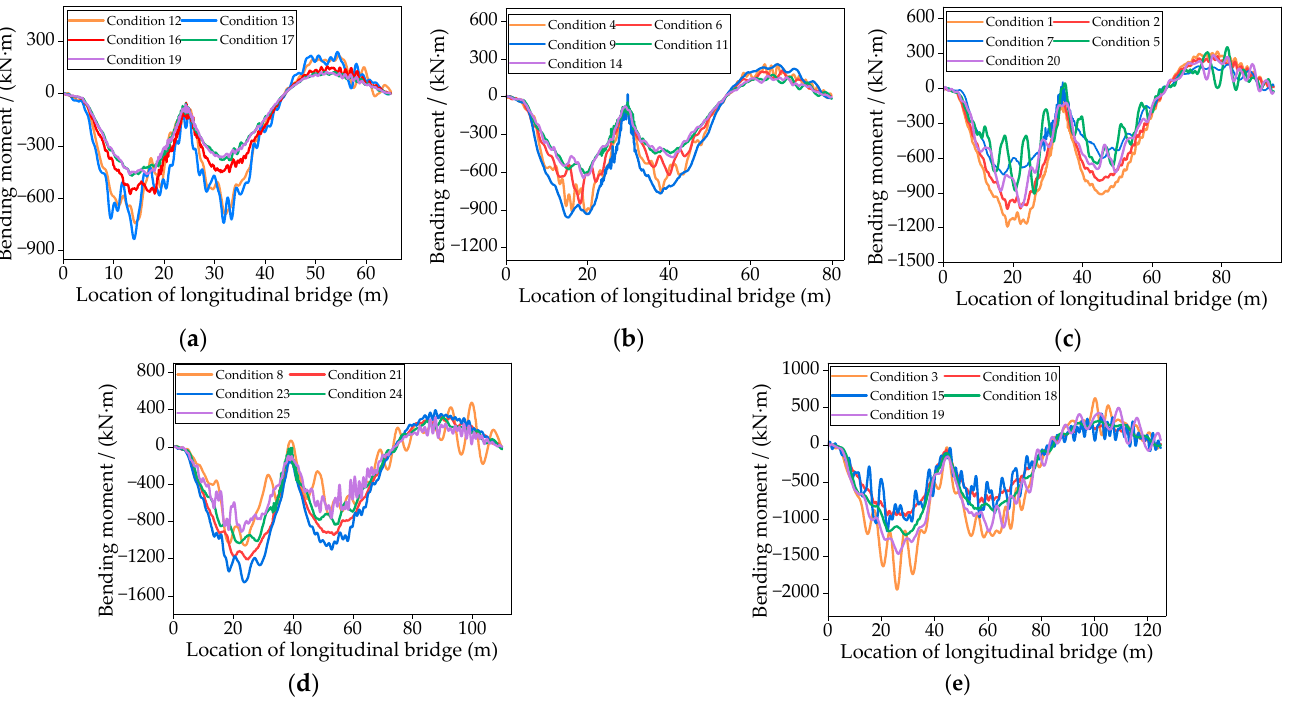
Figure 12. Time-history curves of the negative bending moment in the three-span continuous girder bridges. ( a ) Time-history curves of the bridges with a span of 20 m; ( b ) Time-history curves of the bridges with a span of 25 m; ( c ) Time-history curves of the bridges with a span of 30 m; ( d ) Time- history curves of the bridges with a span of 35 m; ( e ) Time-history curves of the bridges with a span of 40 m.